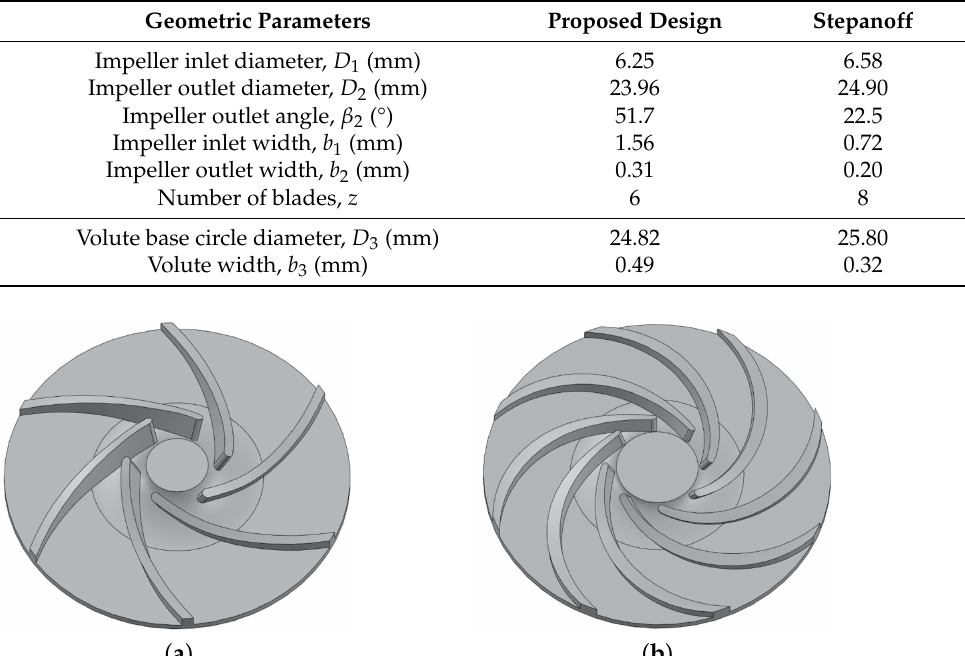
Figure 12. Impeller configuration: ( a ) proposed design method; ( b ) Stepanoff